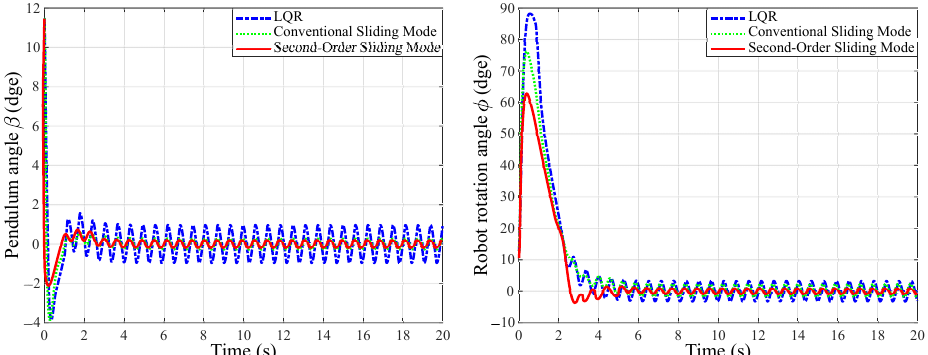
Figure 9. The simulation results with the disturbance compare the angle responses of the inverted pendulum on β and the robot on φ , respectively.